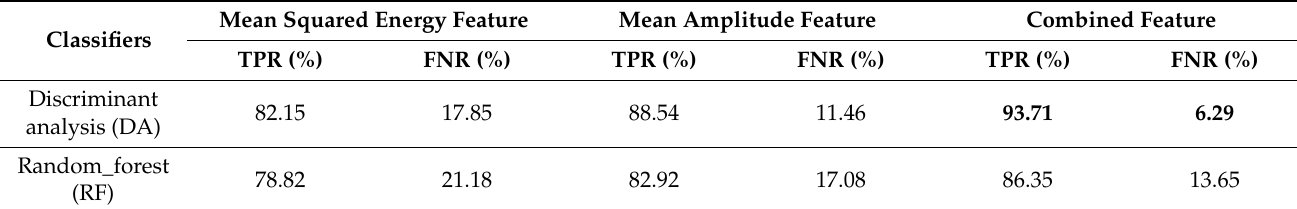
Table 1. The Results of TPR and FNR of two classifiers across the VOC2008 Database.